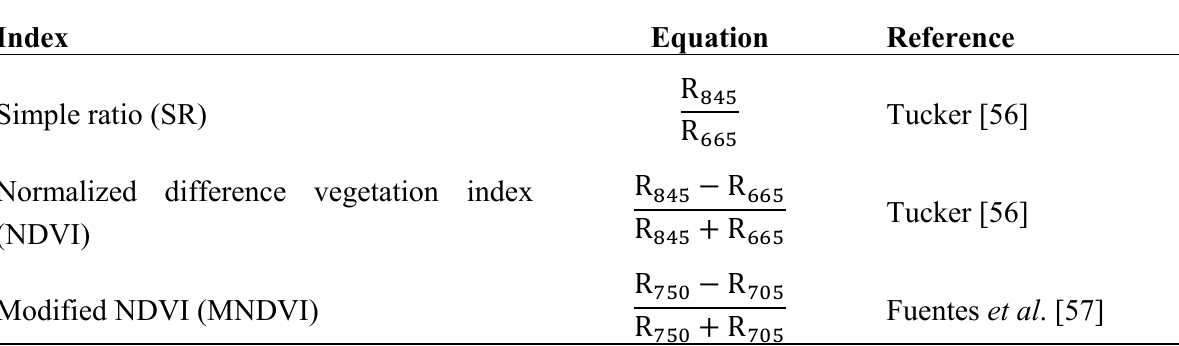
Table 2. Vegetation indices used in the decision tree